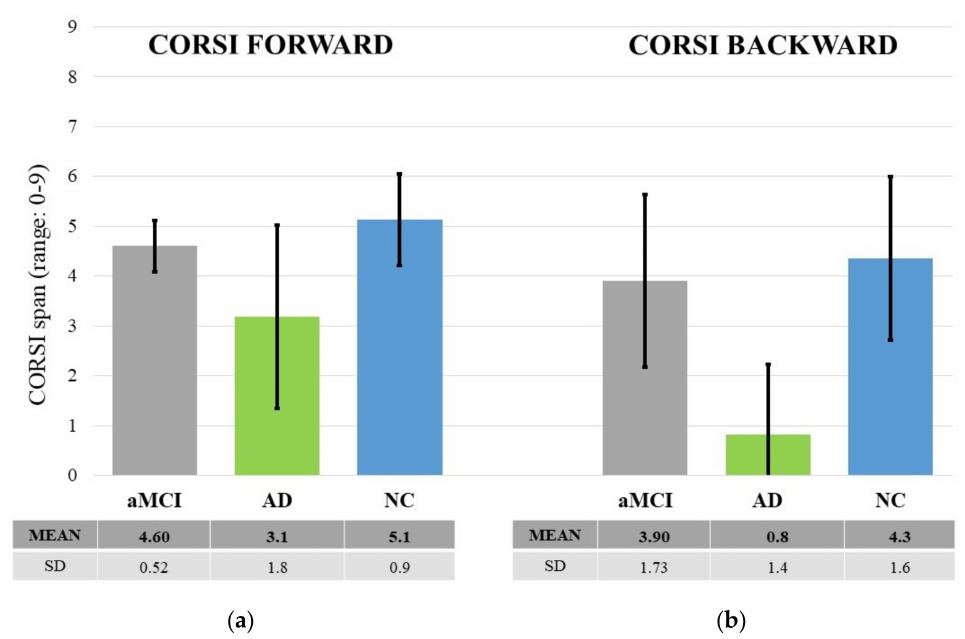
Figure 7. The graph shows the scores at CORSI Forward ( a ) and Backward ( b ) as a function of the three groups of participants (aMCI, AD and NC). The black lines represent the standard deviation. Descriptive statistics are also shown in the table below the graph.